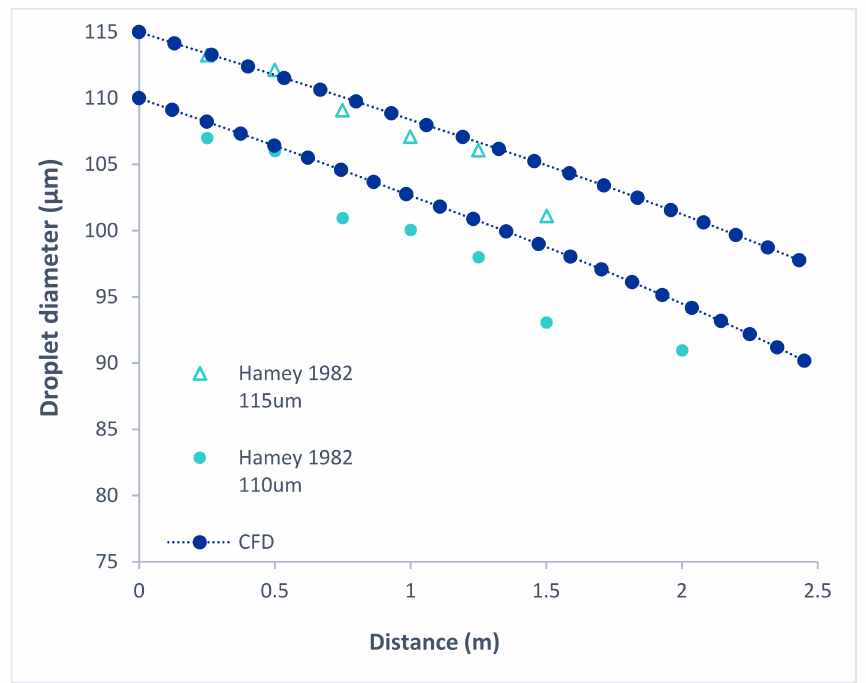
Figure 2. Freely falling water droplets based on the study of Hamey (1982). Particle sizes of 110 µ m and 115 µ m, environment temperature 293 K, particle temperature 289 K, and 70% relative